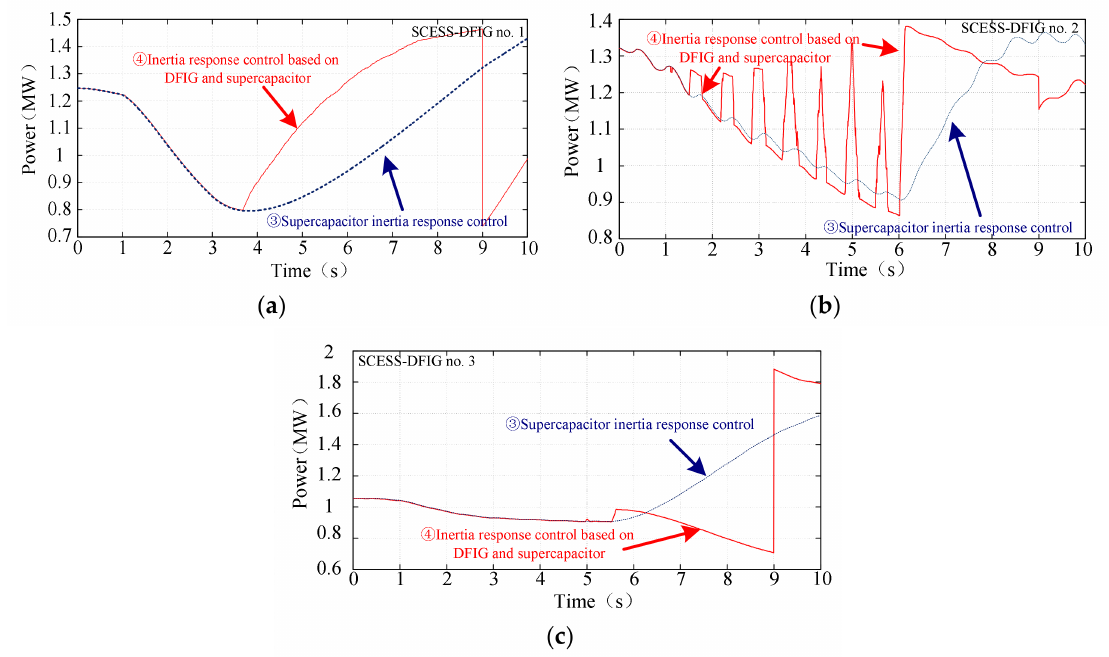
Figure 17. Comparison of SCESS-DFIG stator output power under different control strategies: ( a ) No. 1 SCESS-DFIG stator output power under different control strategies; ( b ) No. 2 SCESS-DFIG stator output power under different control strategies; ( c ) No. 3 SCESS-DFIG stator output power under different control strategies for SCESS-DFIG no. 3.